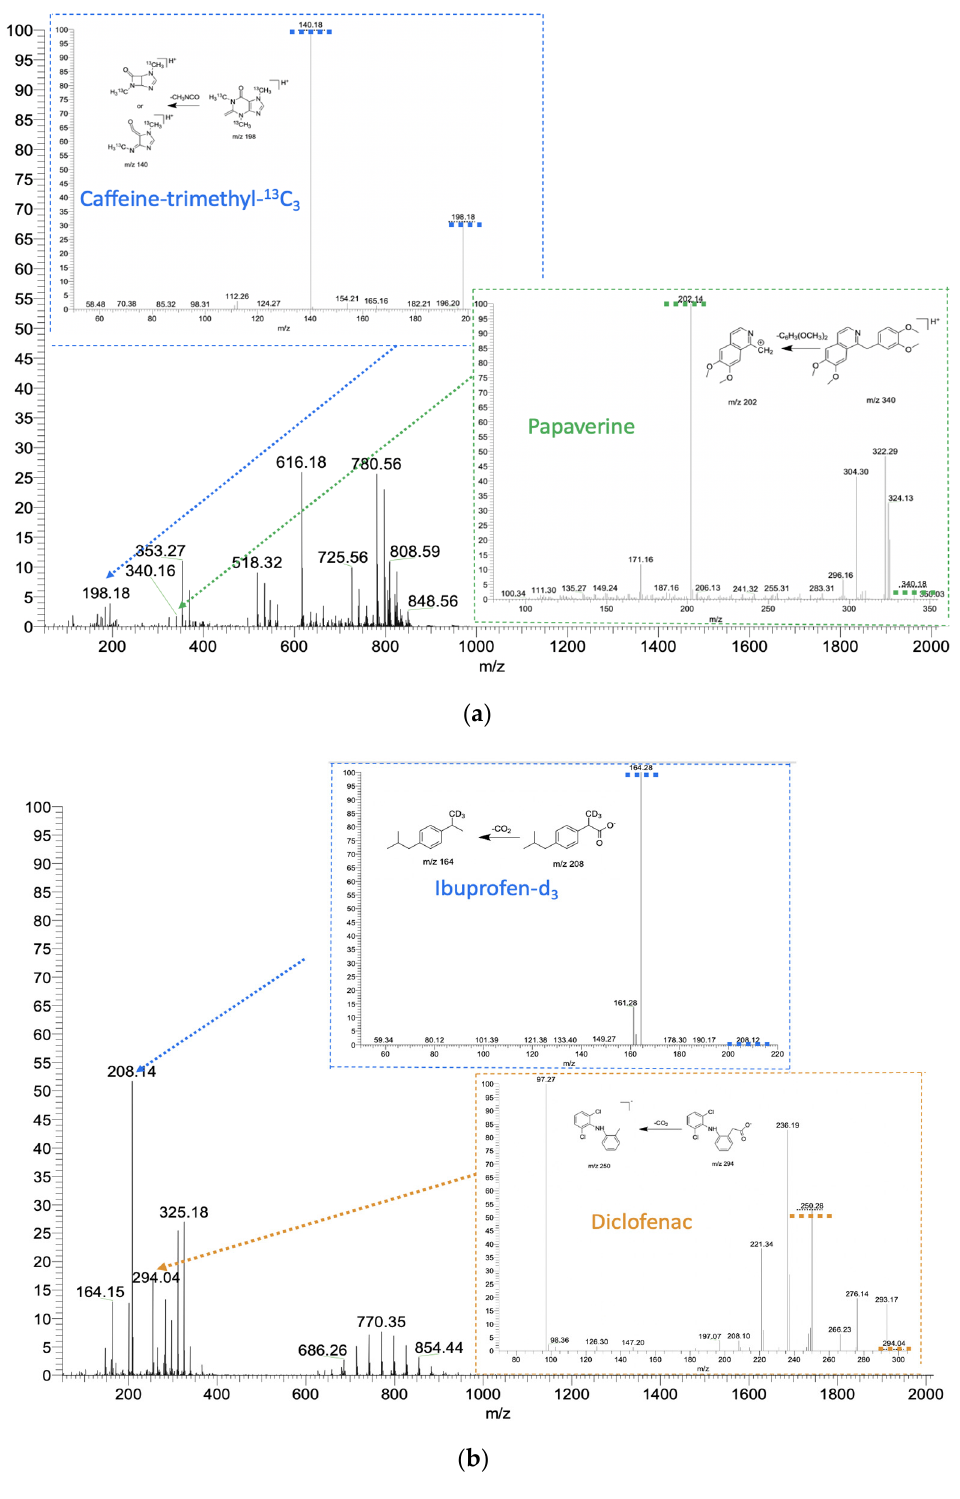
Figure 6. ( a ) Mass spectra of drugs (papaverine 2500 ng/mL and caffeine-trimethyl- 13 C 3 a 100 μ g/mL as an internal standard) in blood in positive ion mode. Spray solvent is 9:1 ( v / v ) methanol:H 2 O with 0.1% ( v / v ) formic acid. Spray voltage is 5 kV. ( b ) Mass spectra of drugs (diclofenac 2000 ng/mL and ibuprofen- d 3 100 μ g/mL as an internal standard) in blood in negative ion mode. Spray solvent is 1:1 ( v / v ) methanol: 2-propanol. Spray voltage is 4.5 kV.